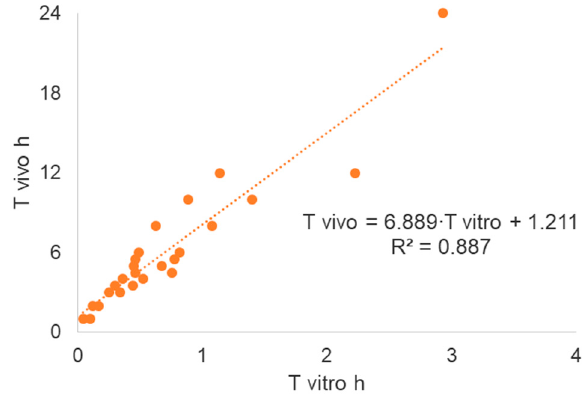
* Indicated excluded value for the Levy plot.